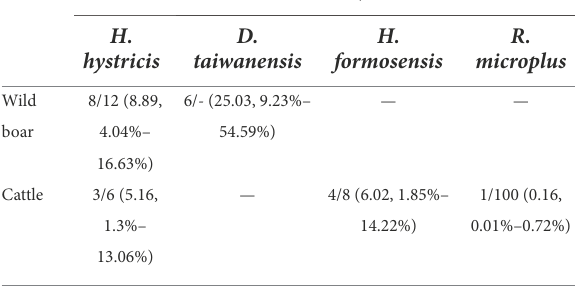
TABLE 3 Prevalence of MHMV in tick pools screened by